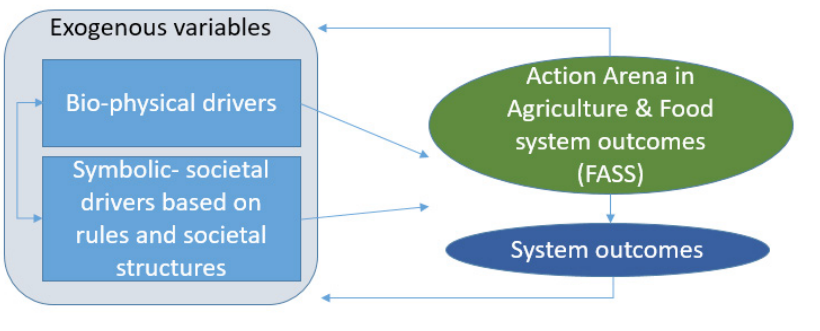
Figure 2: Simplified model of the drivers and Food and Agriculture systems in society (adapted from Ostrom 2005). This frame-work 2 descri- bes the three main phases happening in the main objects (drivers, action arena, system